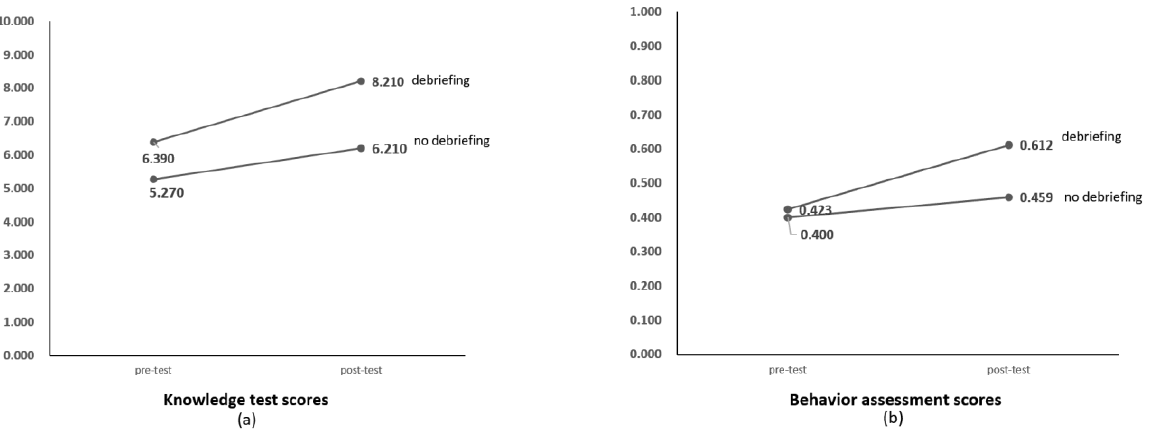
Figure 4. Comparison of the two groups of knowledge and behavior pretest and posttest scores. ( a ) improvement of knowledge test scores, ( b ) improvement of behavior assessment scores.